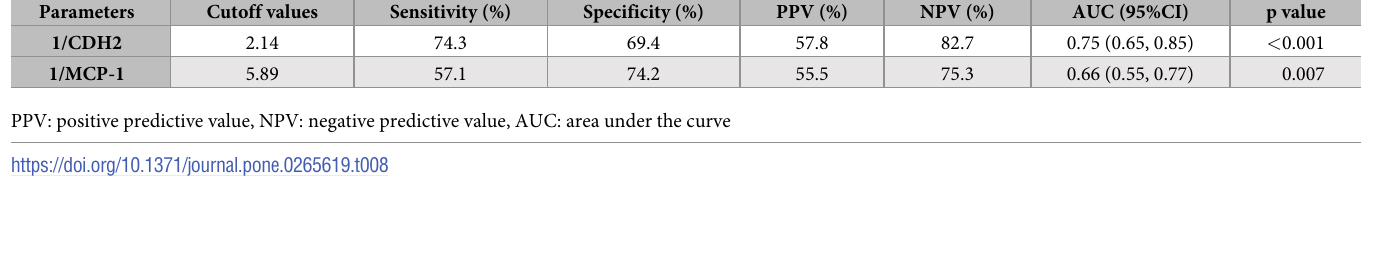
Table 8. Diagnostic performance of 1/CDH2 mRNA and 1/MCP-1 mRNA for overt DN detection.